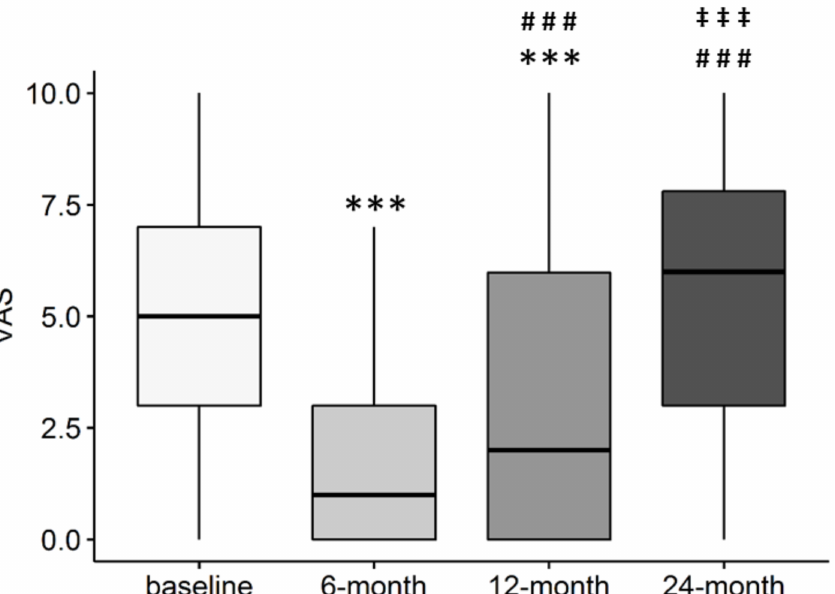
Figure 2. VAS score over time in patients treated with intra-articular injection of MFAT. *** p < 0.001 vs. baseline; ### p < 0.001 vs. 6-month follow-up; ‡‡‡ p < 0.001 vs. 12-month follow-up. pre: n = 202; 6 month: n = 189; 12 month: n = 181; 24 month: n = 150.